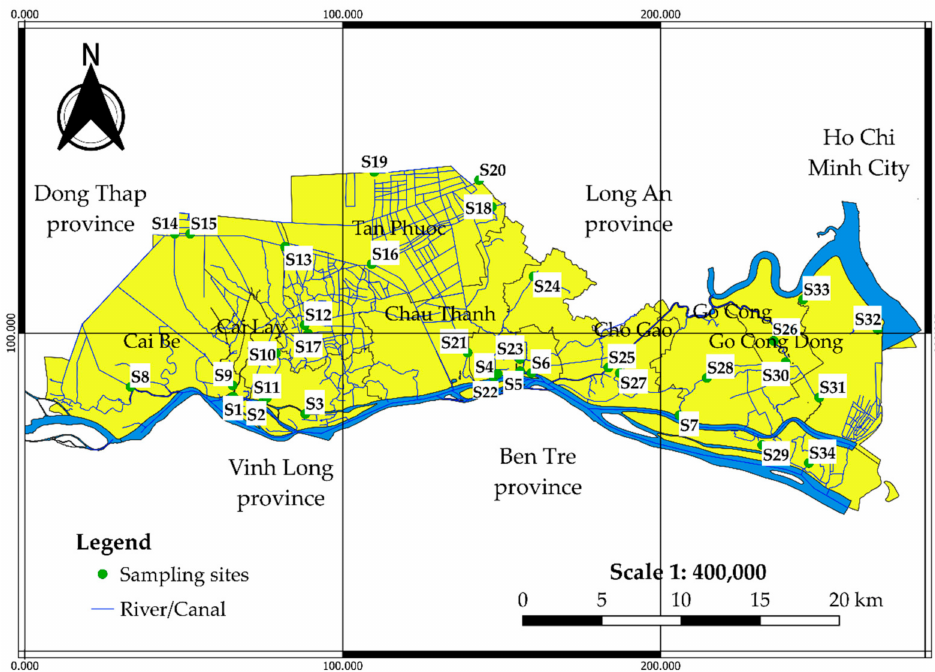
Figure 1. Map of the surface water sampling sites in Tien Giang